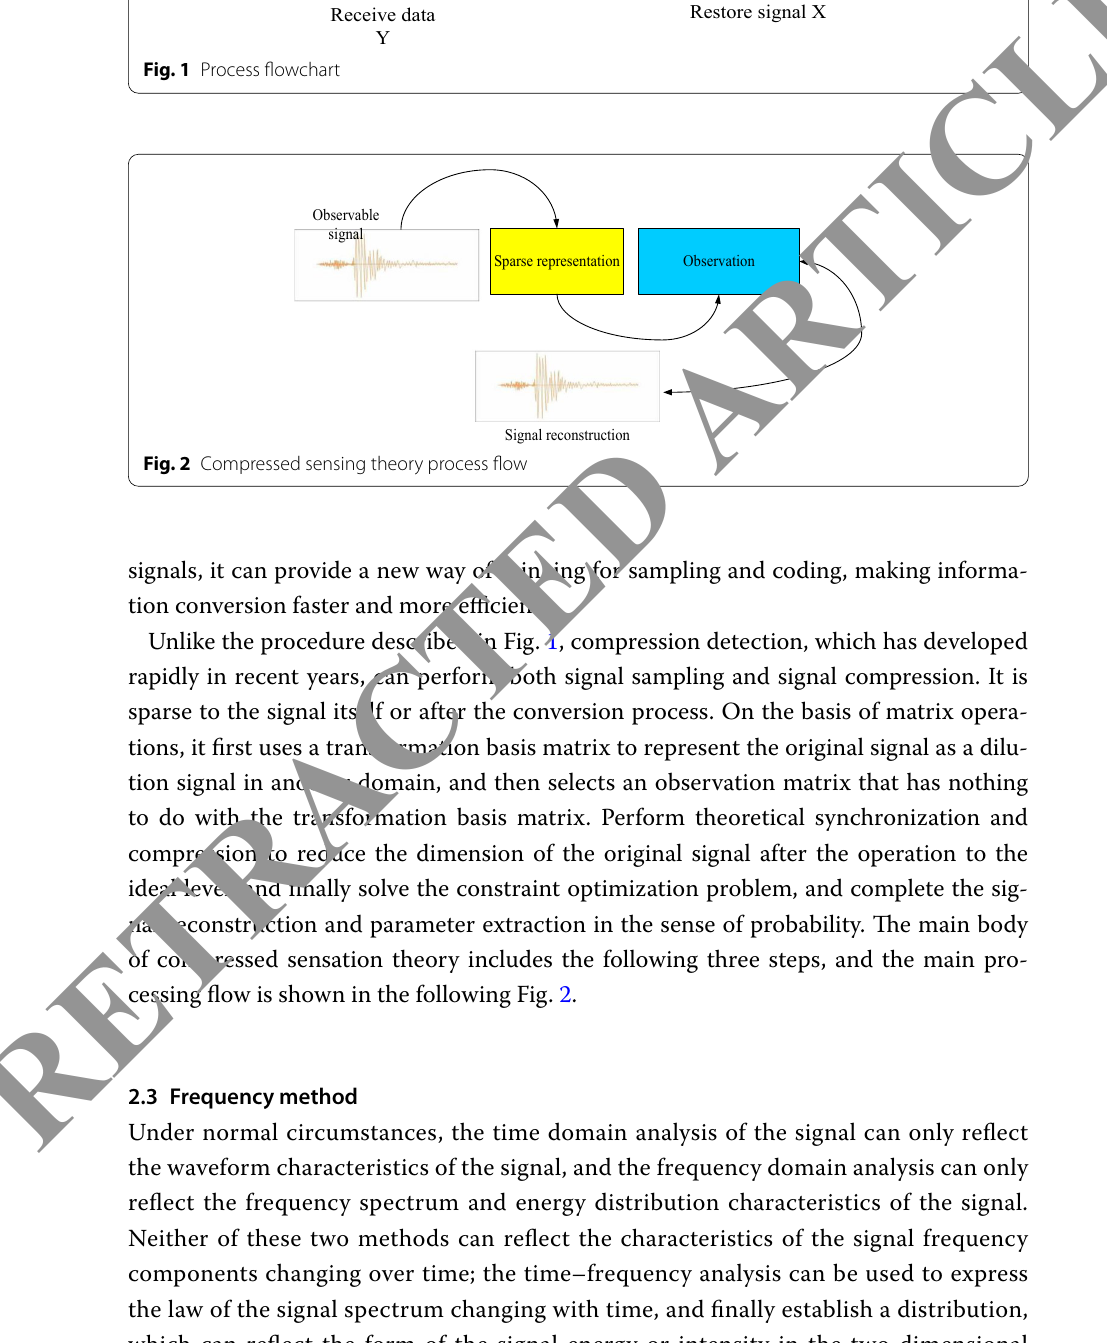
Fig. 1 Process flowchart